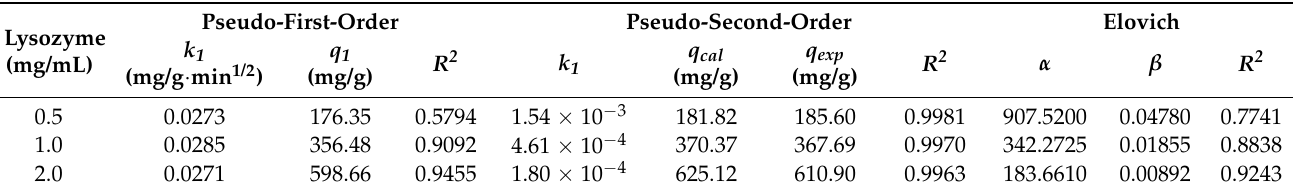
Table 2. Pseudo-first-order, pseudo-second-order, and Elovich kinetic rate constants, calculated and experiment q exp values for the removal of the P-COOH-CS-CEW nanofiber membrane at different dye